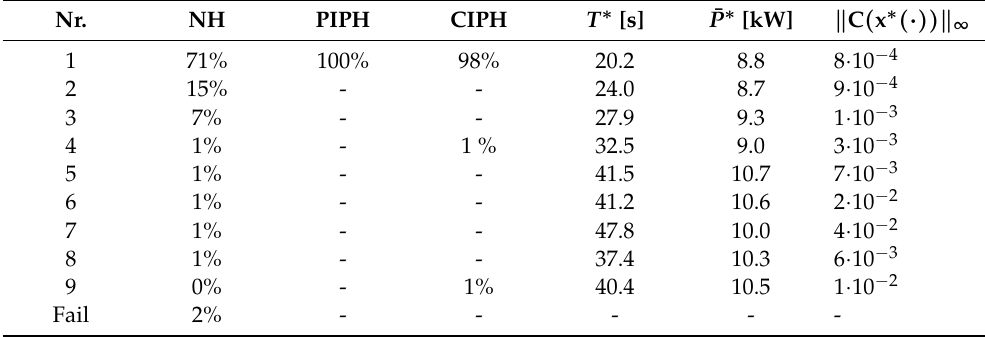
Table 4. Frequency of occurrence in a set of 100 trials, optimal time period T ∗ , average power output ¯ P ∗ , and maximum consistency violation of locally optimal solutions (Nrs. 1 - 9) found by User A. Nr.